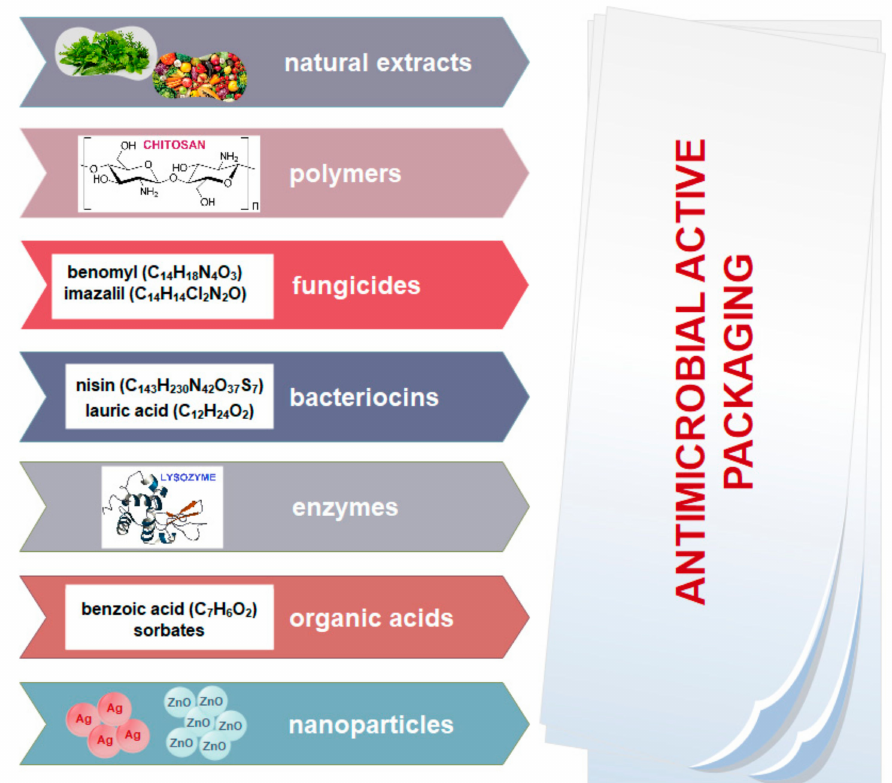
Figure 6. Different antimicrobial substances for antimicrobial active packaging